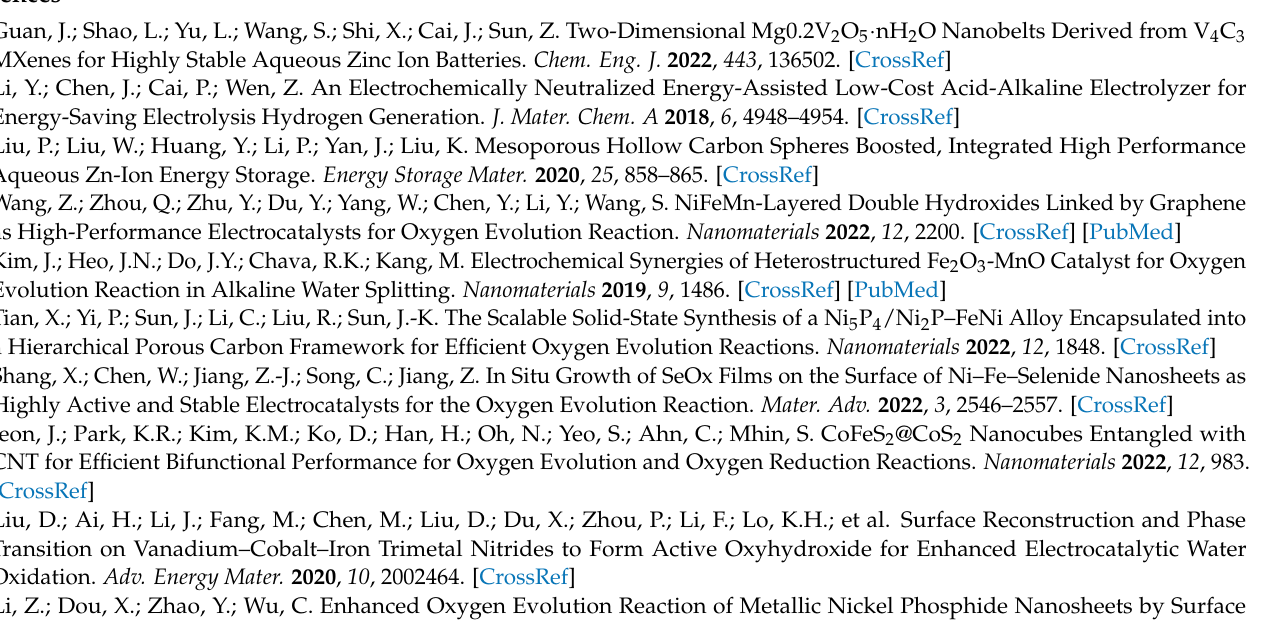
Ni 2 P@Fe 2 P. Figure S7: XPS survey spectra of the Ni 2 P, Ni 2 P@Fe 2 P and Fe 2 P.Figure S8: XRD pat- terns of (a) Fe 2 P and (b) Ni 2 P. Figure S: (a–c) SEM images of LDH with different magnifications. Figure S10: LSV curves of IrO 2 , RuO 2 and Ni foam. Figure S11: CV curves of (a) Fe 2 P, (b) NiFe-LDH, (c) Ni 2 P@Fe 2 P, and(d) Ni 2 P acquired at various scan rates. Figure S12: Durability test of Ir 2 O@10 mA cm − 2 . (b) Nyquist plots. Figure S13: (a,b) SEM images of Ni 2 P@Fe 2 P after LSV test. (c)